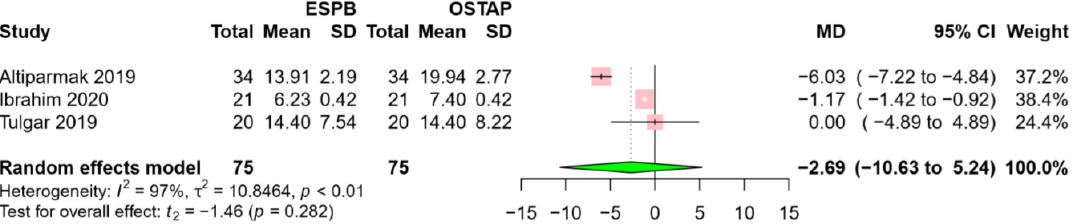
Figure 6. Forest plot for postoperative opioid consumption. Opioid consumption was comparable between the ESPB group and the OSTAP group. Abbreviations: ESPB, erector spinae plane block; OSTAP, oblique subcostal transversus abdominis plane block; SD, standard deviation; MD, mean difference; CI, confidence interval .